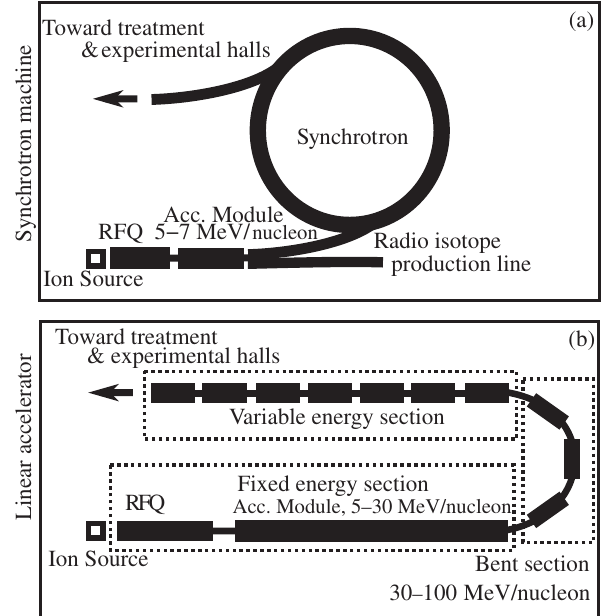
FIG. 1. (a) The NIMMS reference synchrotron layout for the NIMMS facility. (b) The full high-frequency linac design for C 6 þ acceleration [8]. Note the schematic layouts are not to